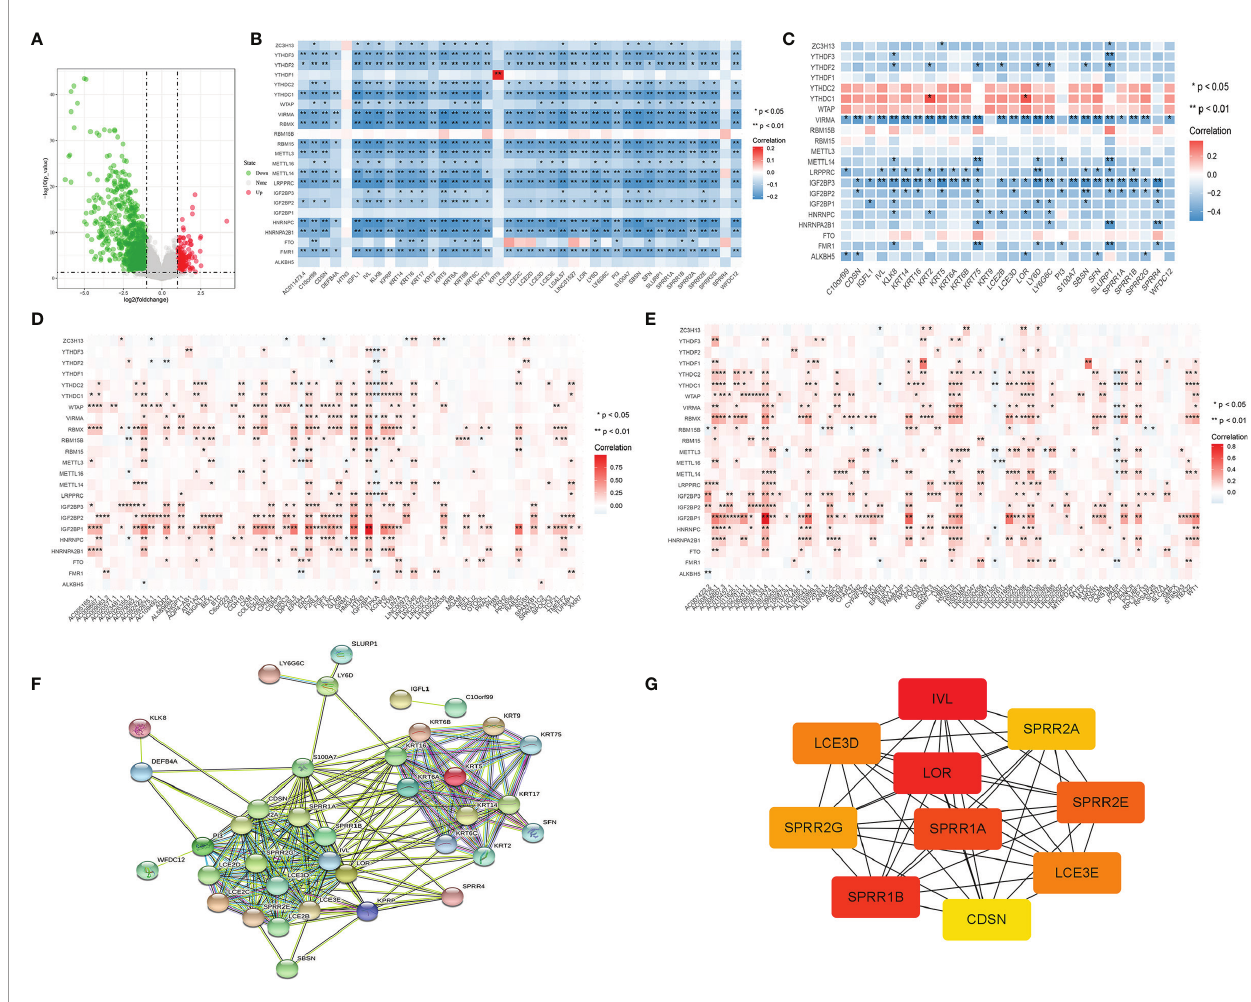
FIGURE 8 | (A) Volcano map of metastasis-related differential gene screening; (B) log FC> 4 differences in gene regulation and m6A factor correlation analysis results; (C) log FC> 4 differences in gene regulation and m6A factor correlation analysis (GSE15605 dataset); (D, E) High differences in gene expression and metastatic carcinoma m6A regulation factor correlation analysis results; (F) log FC> 4 gene transfer difference of protein interaction network; (G) log FC> 4 transfer difference gene protein interaction networks at the core of the gene (the node color said correlation degree, the red associated with surrounding the